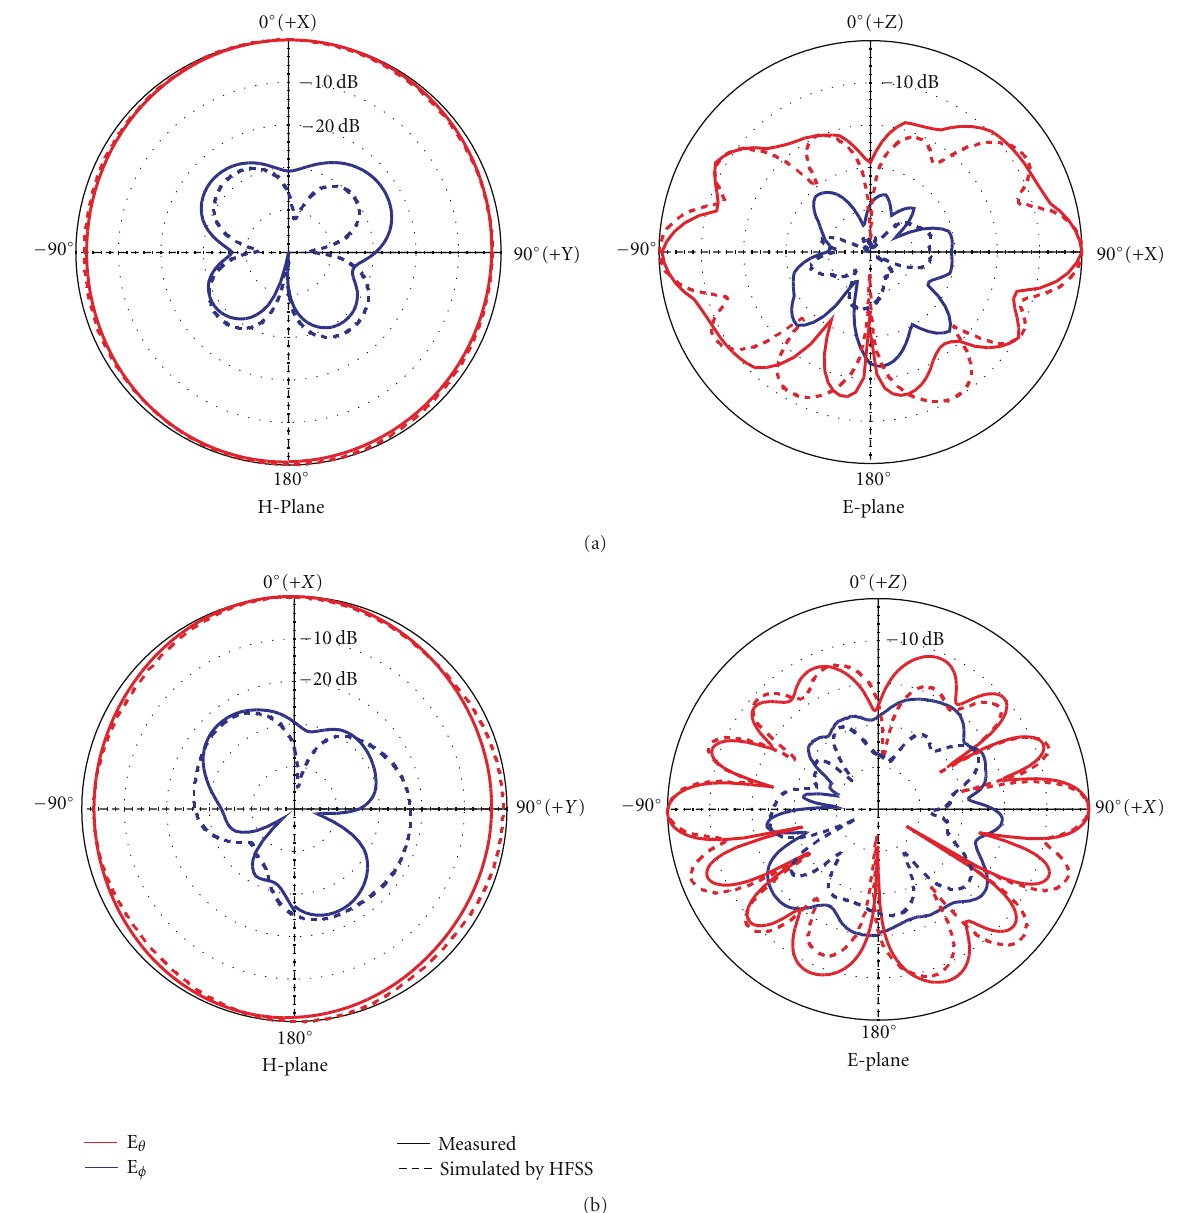
Figure 4: Simulated and measured 2D radiation patterns for the proposed dual-band dipole array. (a) f = 2600 MHz. (b) f = 3500